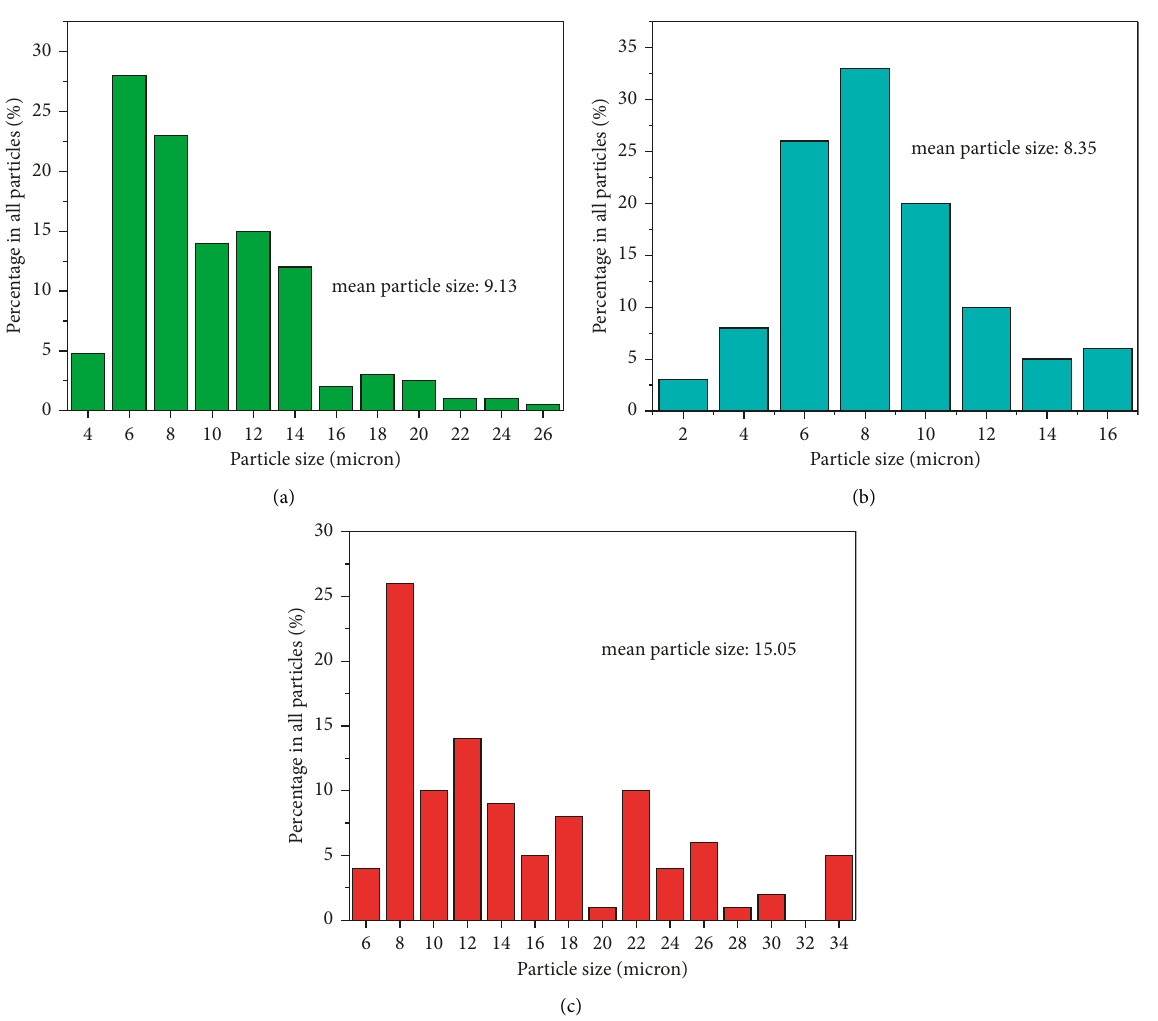
Figure 2: Size distribution of reinforcing particles in the composites: (a) 15v% BN/Al-2048, (b) 10v% WC/Al-2048, and (c) 20v% WC/Al-